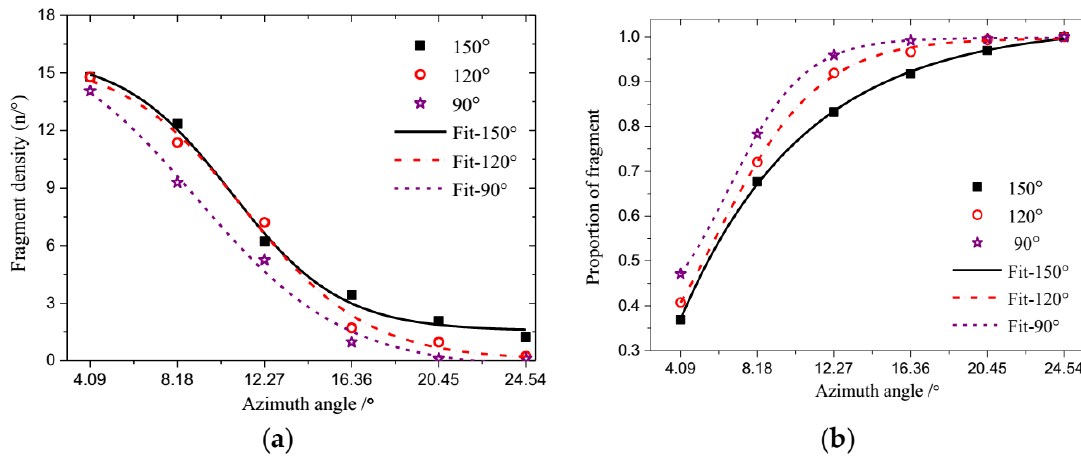
Figure 8. Relationships between the fragment density, proportion of fragment and azimuth angle. ( a ) Fragment density vs. azimuth angle; ( b ) proportion of fragment vs. azimuth